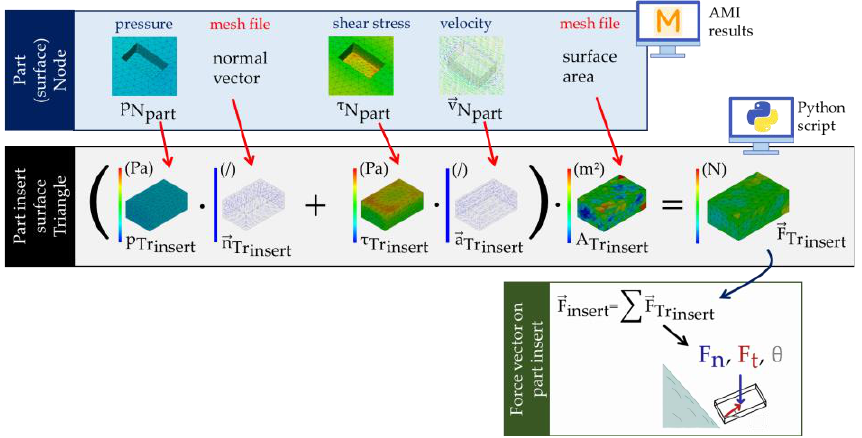
Figure 5. Illustration of the Python API script’s functional principle.